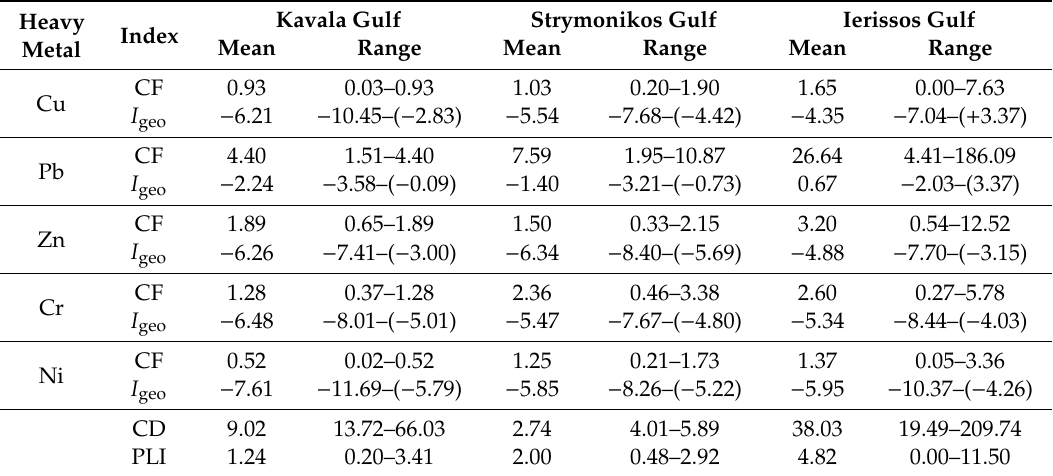
Table 4. The contamination factor (CF) 1 , geoaccumulation index (I geo ) 2 contamination degree (CD) 3 , and the pollution load index (PLI) 4 of heavy metals in surface sediments from three gulfs, North Aegean Sea, Greece: Mean and Range